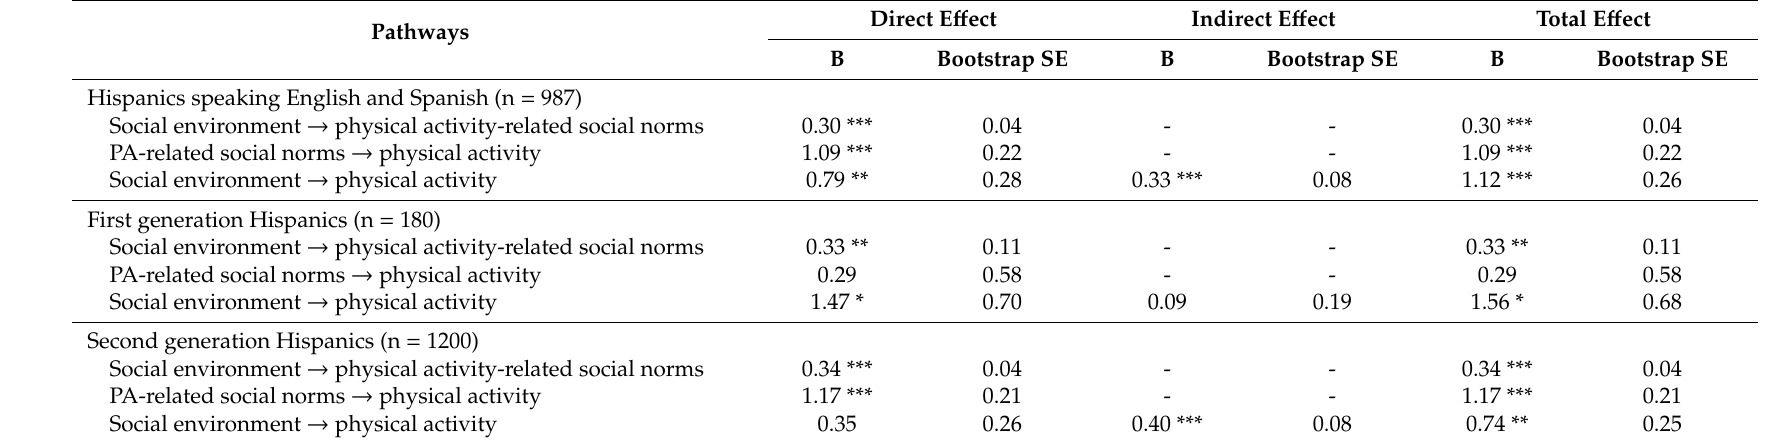
Table 6. Total, direct, and indirect e ff ects of the social environment and physical activity-related social norms on physical activity after bootstrapping. Pathways